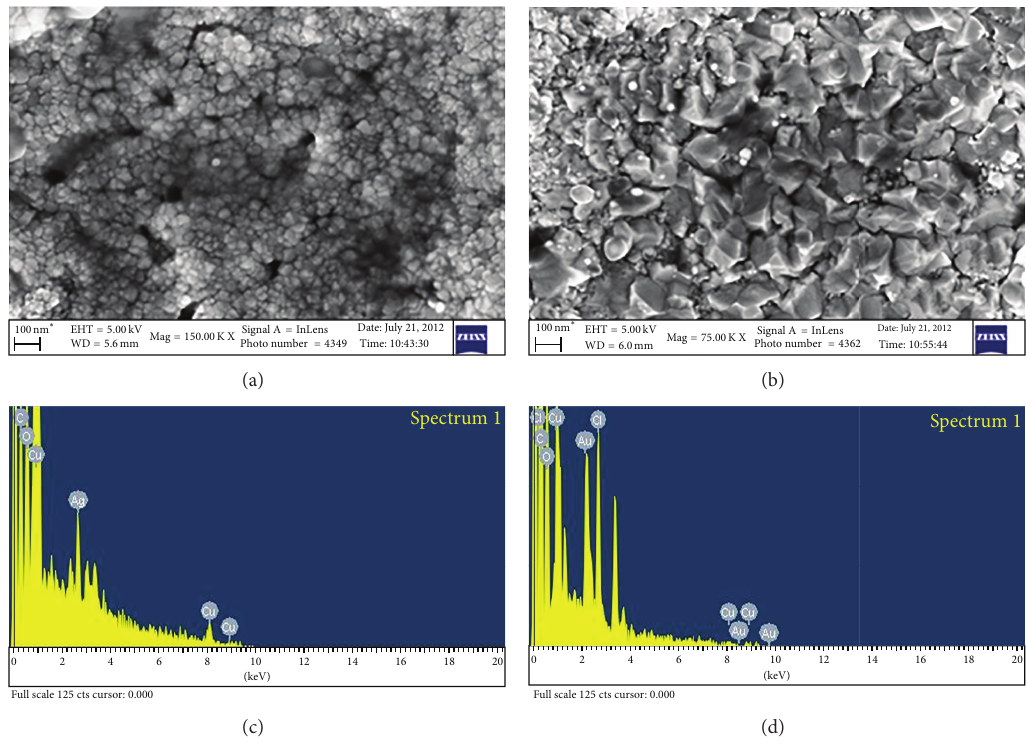
Figure 4: FESEM image of Ag (a) and Au NPs (b) with EDX graph of Ag (c) and Au (d).